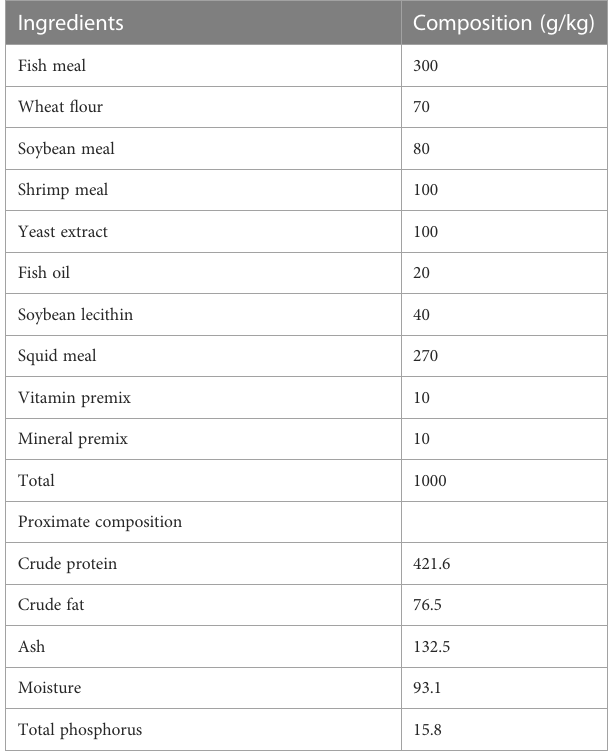
TABLE 1 Formulation and proximate composition of experimental diets (air dry basis,